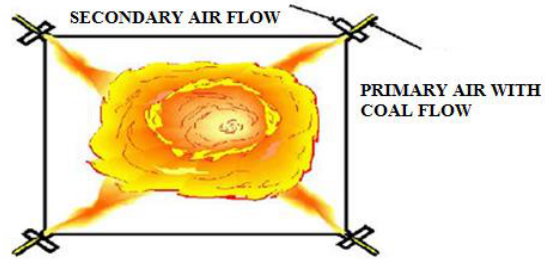
Figure 8. Flame condition inside the boiler.